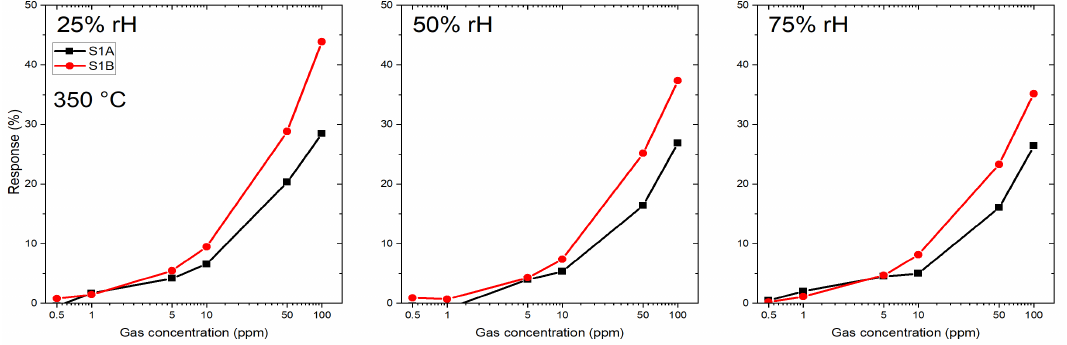
Figure 10. Calculated response of SnO 2 nanowires-based membrane sensors towards HCMix at 350 ◦ C: 1A and 1B — both of them prepared by the same